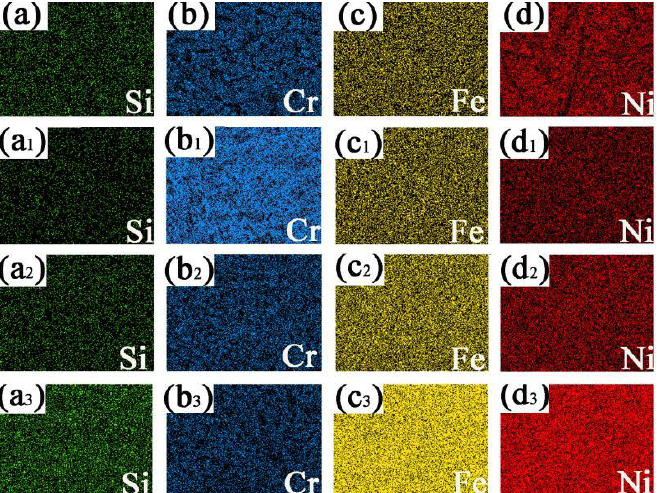
Figure 4. Element distribution of the composite coatings with different thermal treatment tempera- tures: ( a – d ) 25 °C-2%CeO 2 ; ( a 1 – d 1 ) 500 °C-2%CeO 2 ; ( a 2 – d 2 ) 600 °C-2%CeO 2 ; ( a 3 – d 3 ) 700 °C-2%CeO 2 .